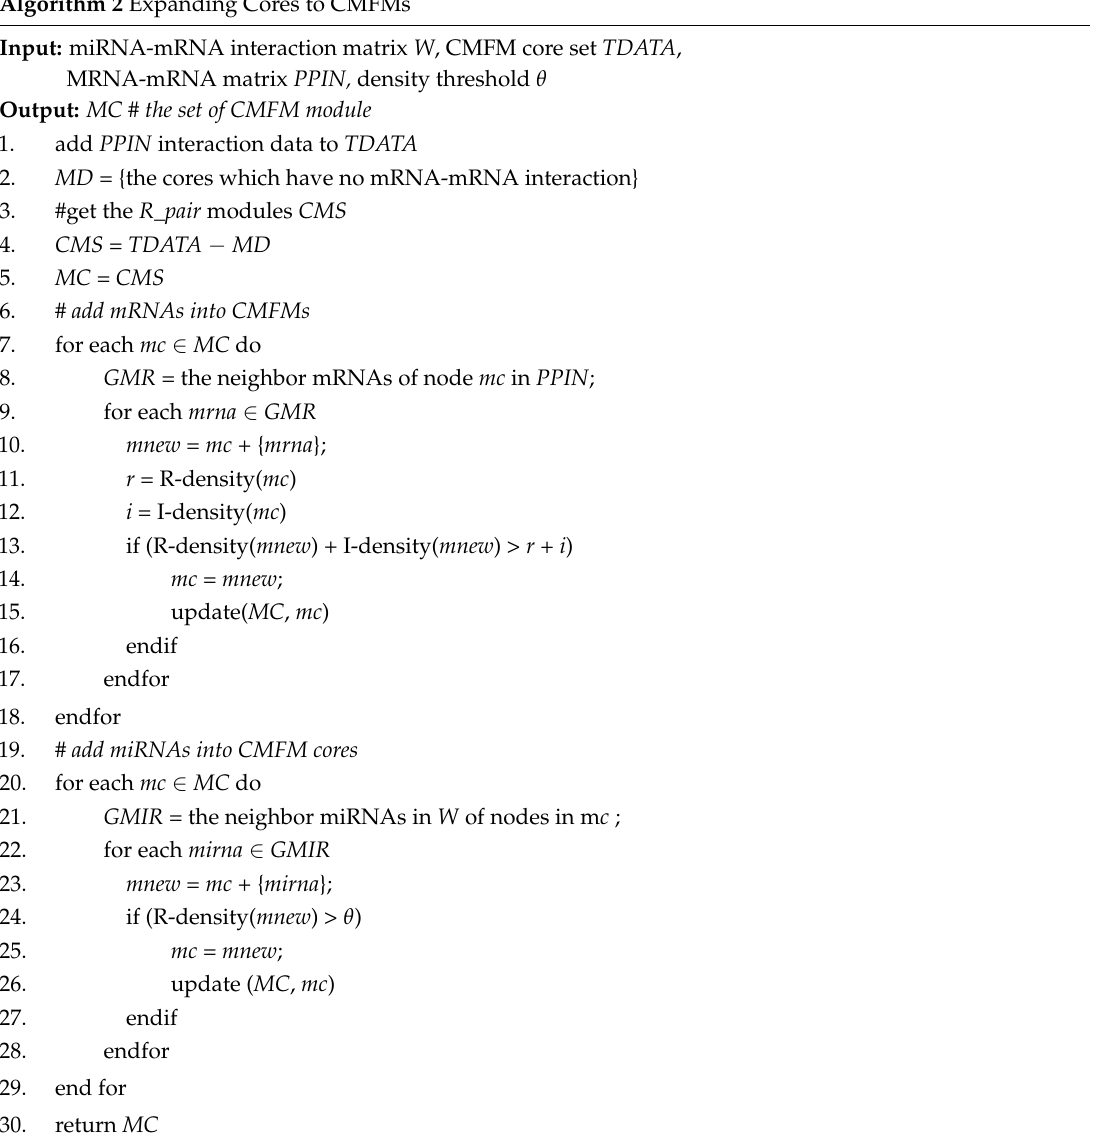
Algorithm 2 Expanding Cores to